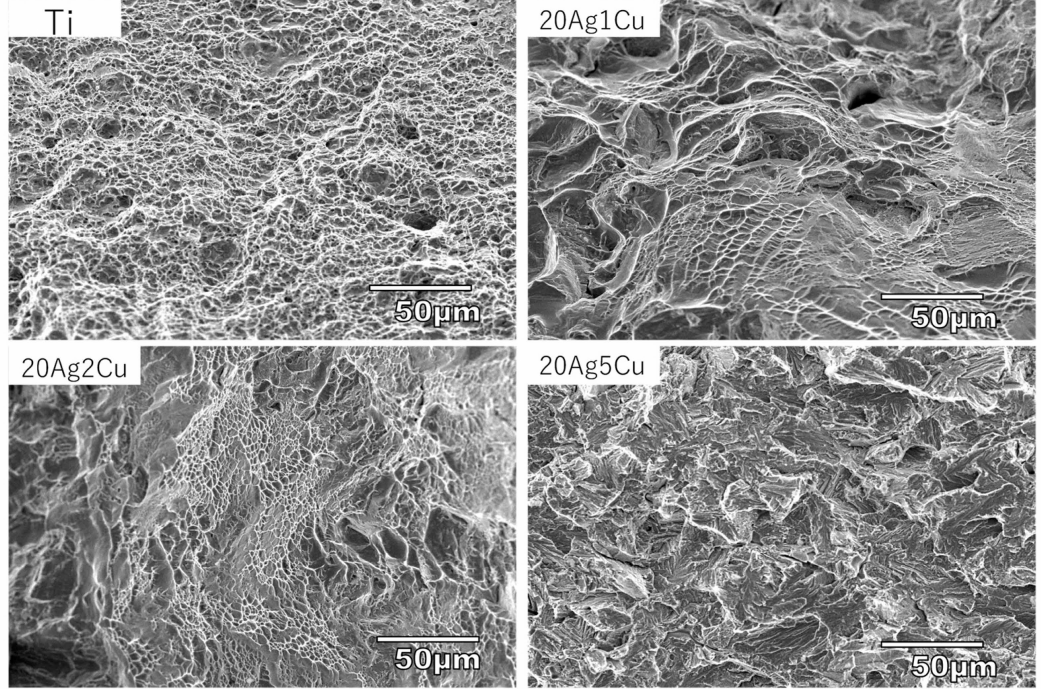
Figure 7. Scanning electron micrographs of the fracture surface of Ti-Ag-Cu alloys after tensile test.